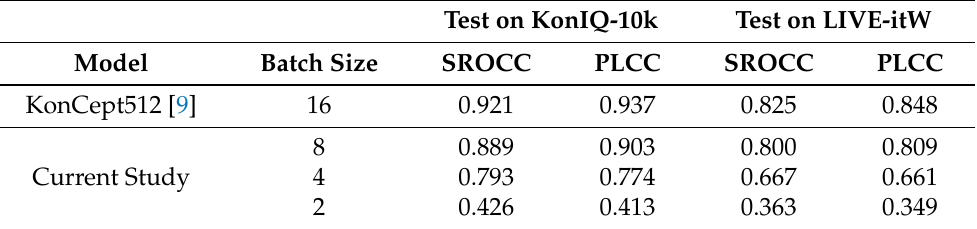
Table 1. Trained model with different batch size compared to the original pre-trained model KonCept512.